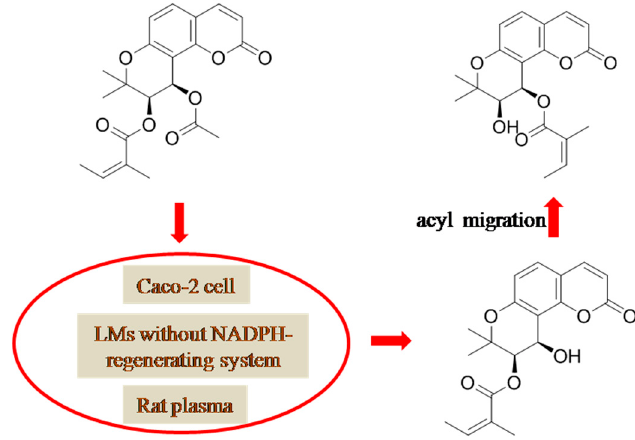
Figure 4. NADPH-independent hydrolysis and intra-molecular acyl migration of praeruptorin A (PA) in Caco-2 cells, in rat/human liver microsomes in the absence of NADPH-regenerating system, and in fresh rat plasma. LM: liver microsomes. The structures of the two cis -khellactone glucuronides were tentatively assigned on the basis of the speculation in [31].